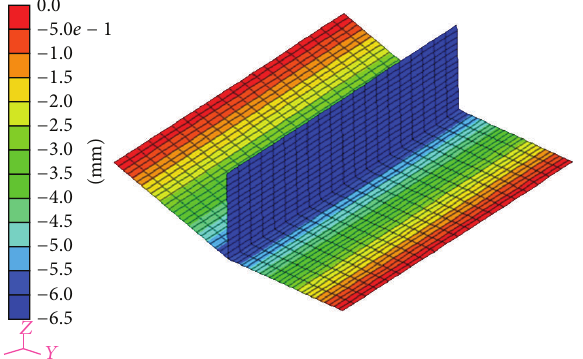
Figure 6: 𝑍 -displacement of fillet joint model calculated by elastic FEM.